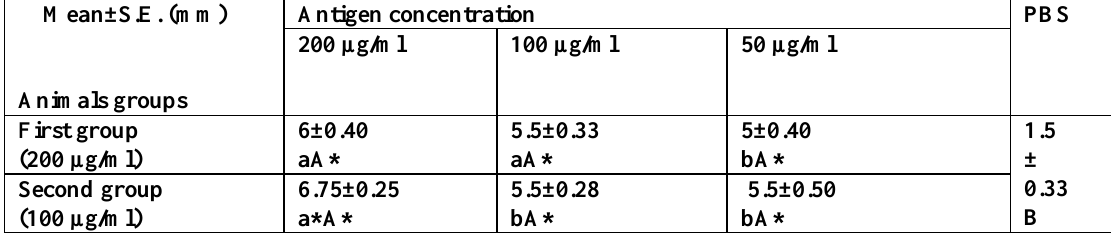
Table 2: Indurations of delayed type hypersensitivity in the immunized rabbits with Proteus vulganis fimbriae antigen after 24